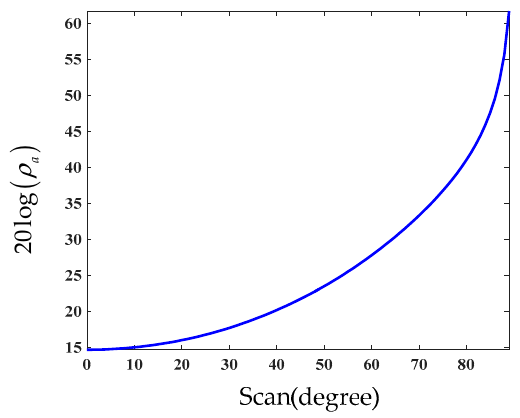
Figure 2. Variation of the azimuth resolution with the scan angle.